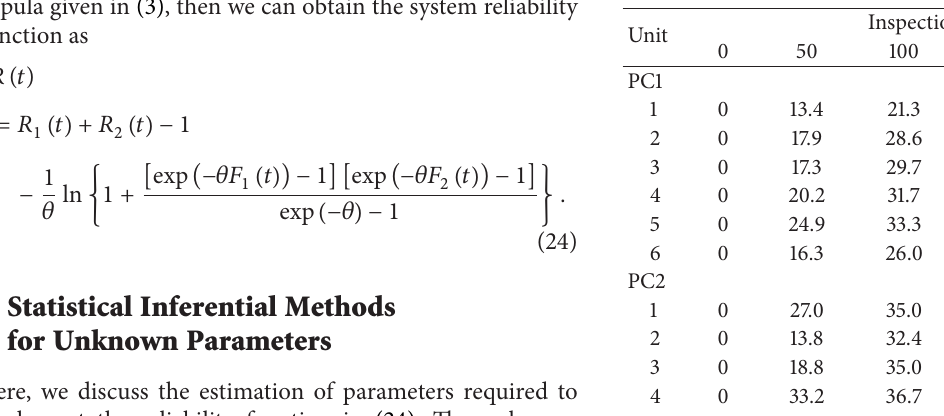
Table 1: Light intensity degradation data of 12